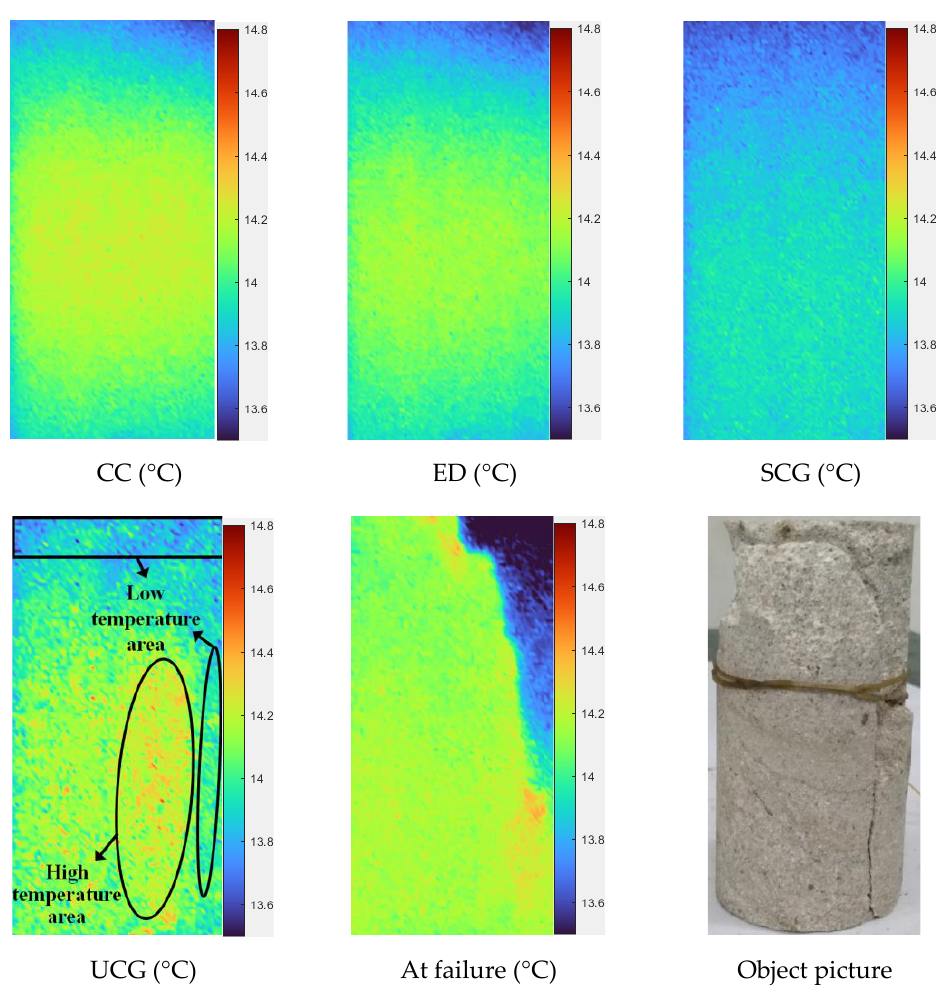
Figure 5. Infrared thermal images (°C) of rock sample A 1 during loading.